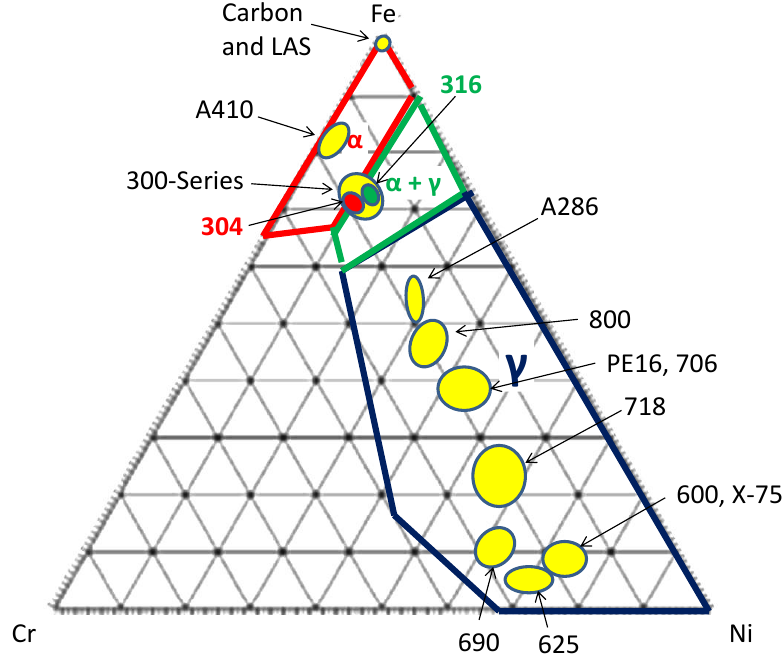
Figure 2. Ternary diagram for the Fe–Cr–Ni system at 400 °C illustrating the approximate compositions (considering Fe + Cr + Ni = 100 at%) of the main structural alloys used in nuclear reactors. The composition range for the stable FCC phase (γ) is outlined in blue. The green region can be metastable, leading to a wide range of possible austenitic, ferritic and martensitic phases that make up the duplex stainless steels. The ferritic BCC phase (α) in the red region illustrates the composition range for the high-strength carbon and low-alloy steels (LAS) and ferritic stainless steels used for pressure vessels and piping. By and large, Fe–Cr–Ni alloys are classed as austenitic steels (as opposed to austenitic Ni alloys) when the Ni content is between approximately 8 wt% and 28 wt%. Alloys are also classed as stainless steels when the Cr content is > 10.5 wt%. The most widely used austenite steel in nuclear reactors is 304 SS, also known as 18/8 because it has a composi- tion of approximately 18 wt% chromium and 8–10 wt% nickel. Austenitic steels have FCC γ-phase (austenite) as their primary phase in the fully austenitic alloys but may also con- tain some BCC α-phase in the duplex alloys as well as minor secondary phases, including carbides and intermetallic phases such as the tetragonal sigma phase. Most (except high- Ni A286) are not precipitation hardenable by heat treatment, yet they can be hardened by cold working and quenching. After deformation, the 304 and 316 steels may contain hex- agonal-close-packed (HCP) ε-martensite, which is easily created from the shear of the par- ent FCC γ-phase. This HCP ε-martensite phase should not be confused with body-centred tetragonal (BCT) α’-martensite that forms from quenching of low-alloy carbon steels be- cause carbon in solid solution distorts the BCC lattice. Metastable martensite associated with the α-phase has a BCT crystal structure. It is formed in ferritic steels when the cooling rate from the high-temperature austenitic γ-